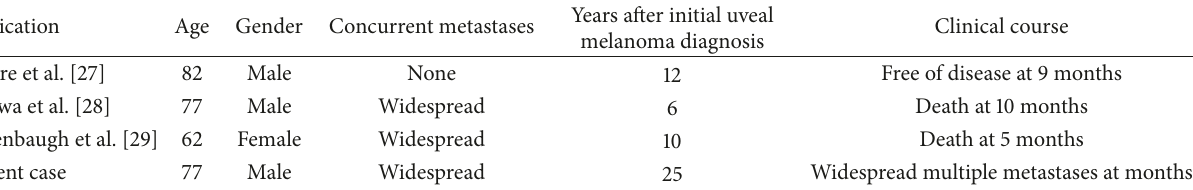
Table 2: Clinical features of the 4 cases of uveal melanoma metastases in the urinary bladder that have been reported so far in the literature.